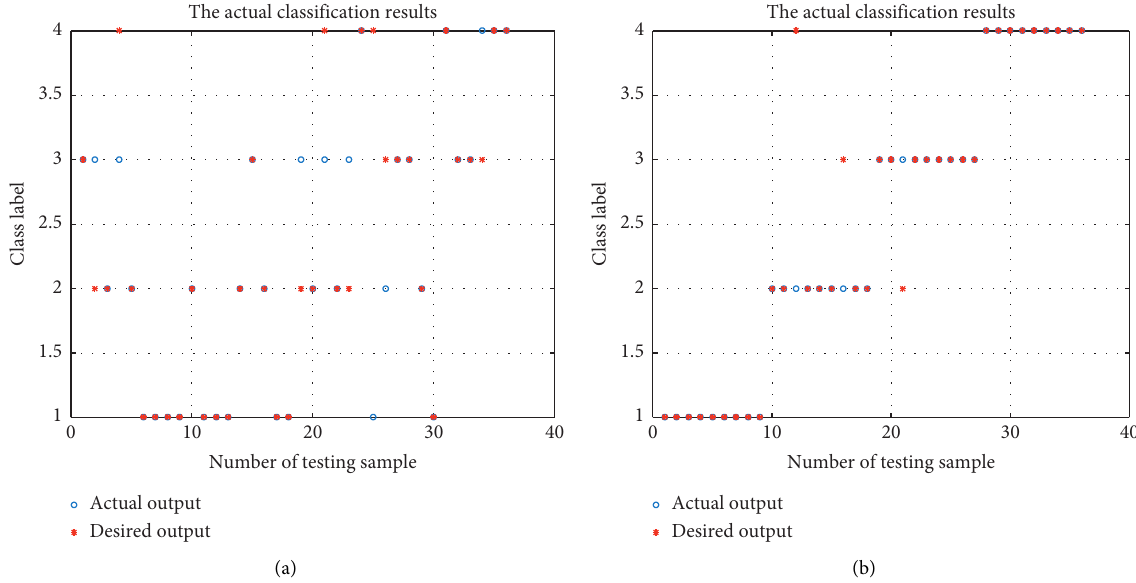
Figure 9: Identification of the numerical simulation based on singular spectral entropy. (a) SVM model. (b) PSO-SVM model.